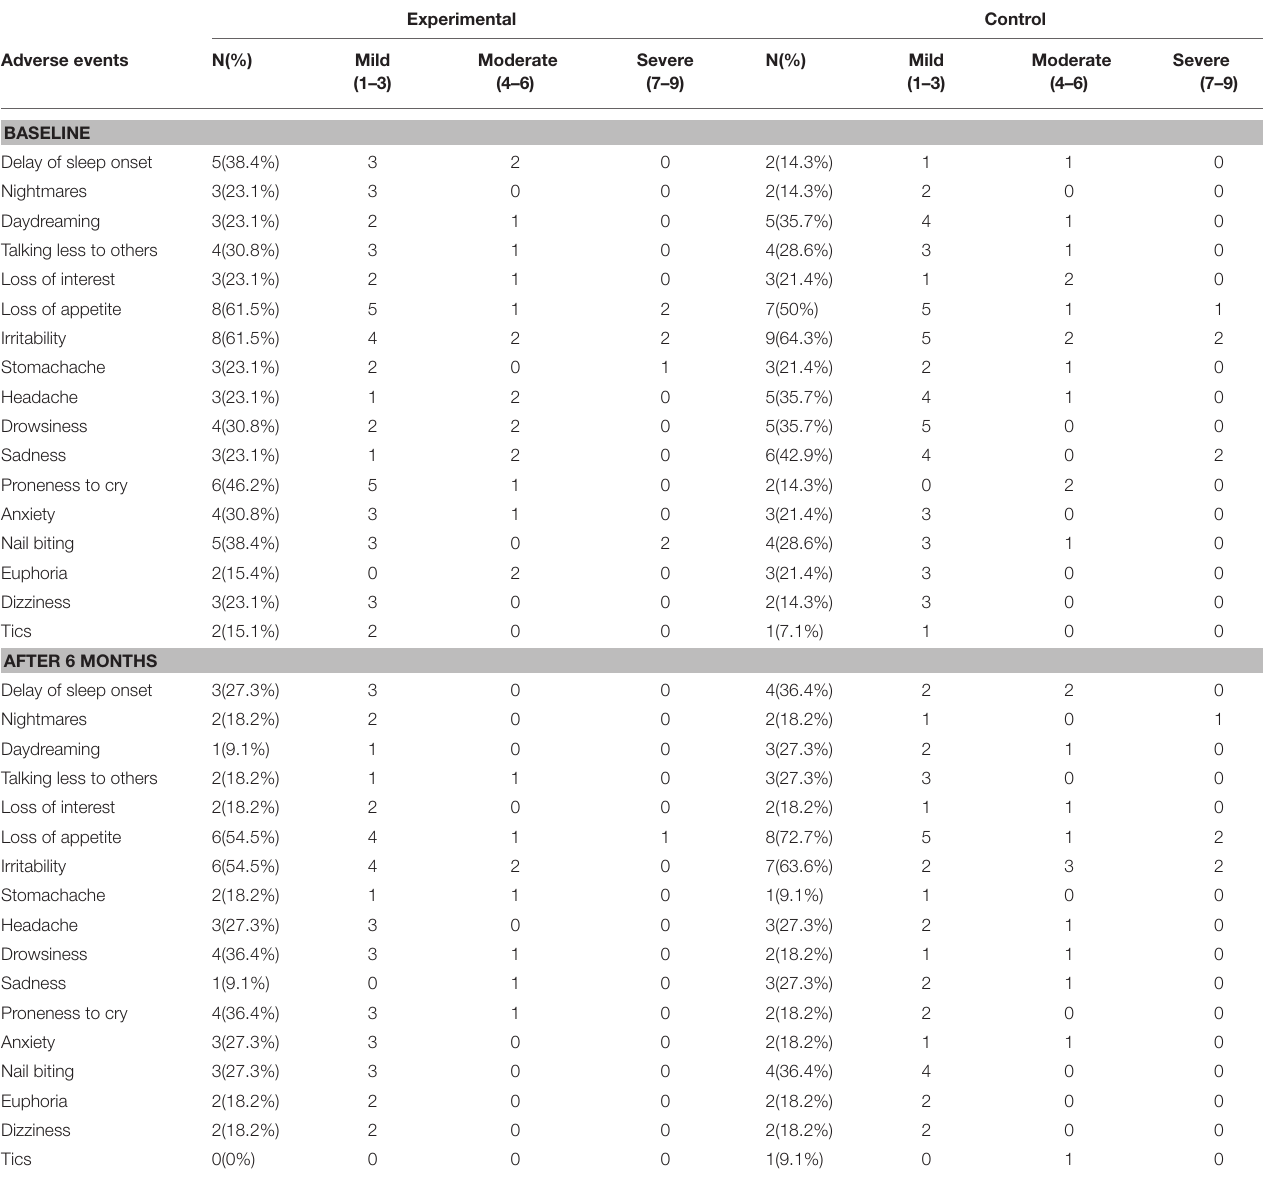
TABLE 3 | Adverse events by